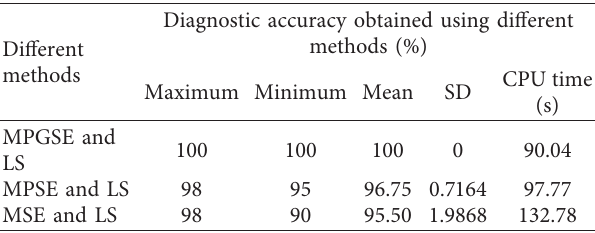
Figure 20: Diagnostic accuracy of 20 trials of three methods in case 1. Table 6: Diagnostic results of different methods with LS feature selection for the A dataset in case